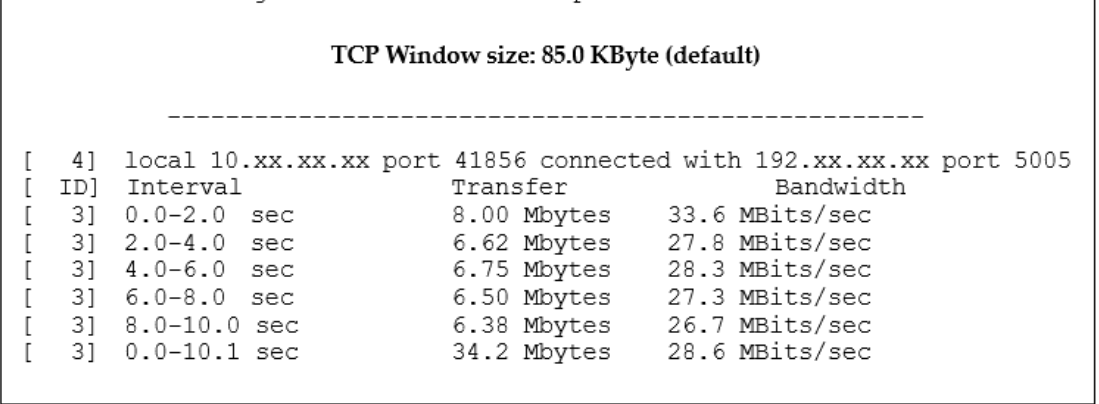
Figure 13. Iperf measurement